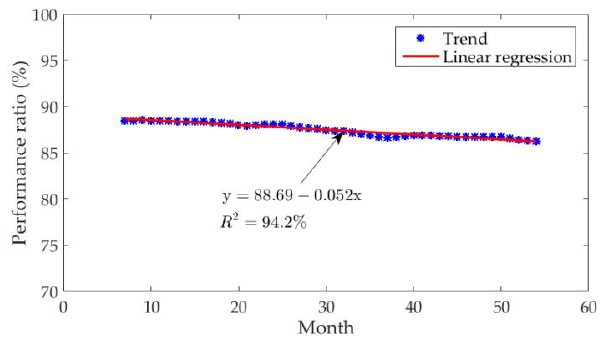
Figure 11. Trend component and its linear regression for mono-Si PV.